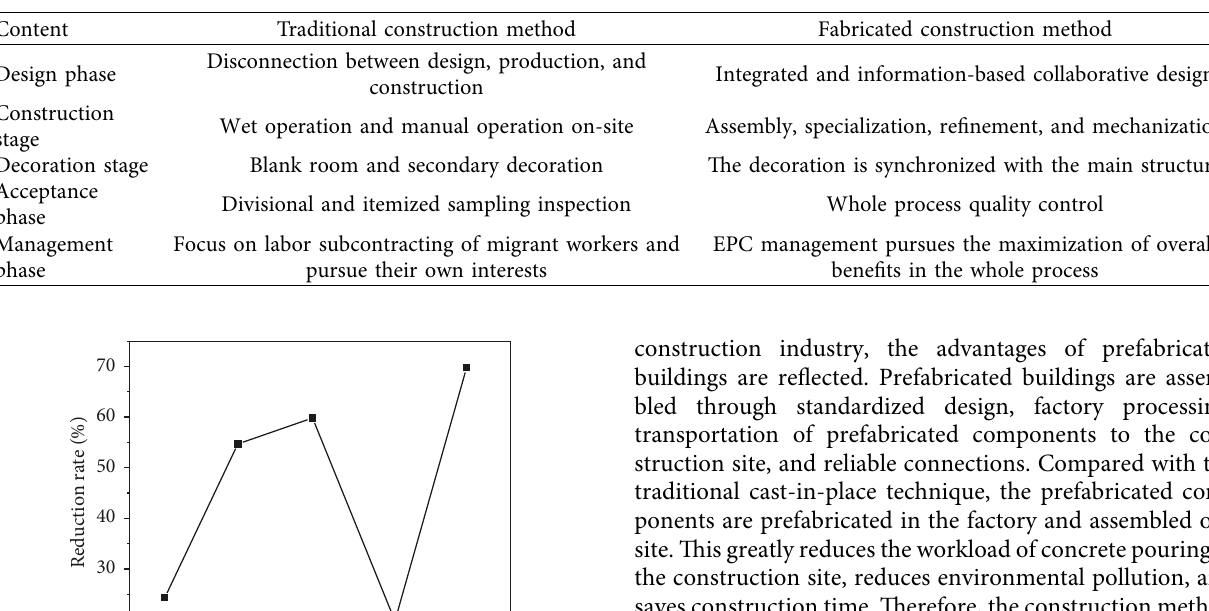
Figure 2: Intelligent construction system of the prefabricated building based on BIM. Table 1: Core connotation of prefabricated buildings.